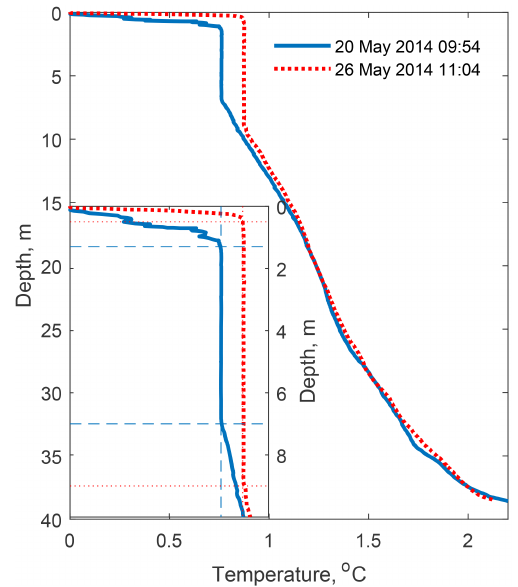
Figure 4. Temperature profiles at the beginning (solid line) and at the end (dotted line) of the field study. The inset shows a zoomed portion with CL and temperature gradients at its